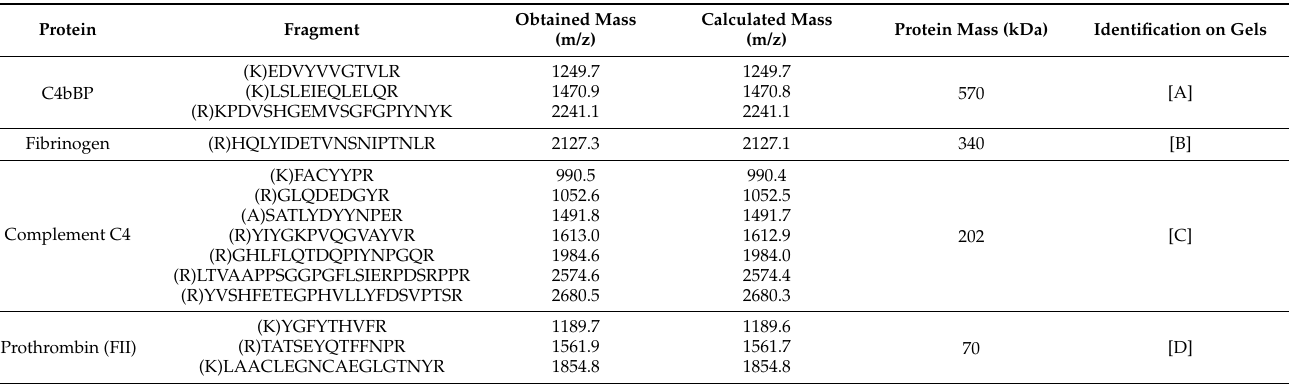
Cysteine residues were either modified by acrylamide, C(Propionamide) or were unmodified, as for the peptide with m/z